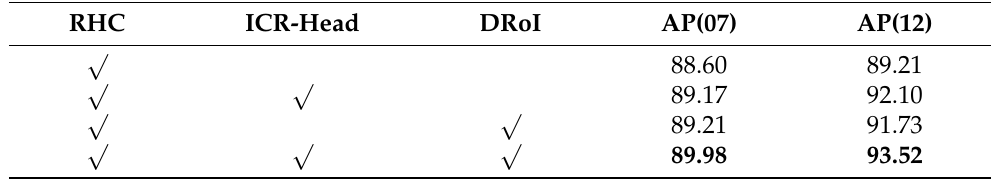
Table 2. Ablation study of OSCD-Net on the HRSC2016 dataset. The highest value is indicated by bold numbers